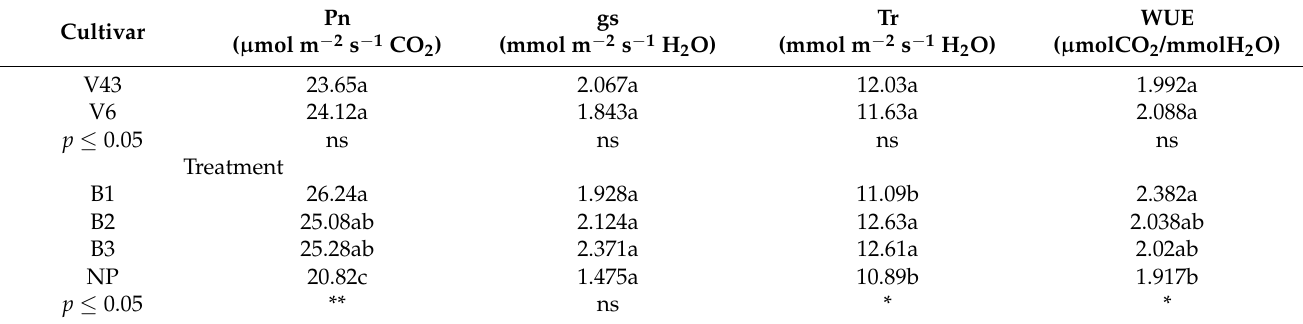
Table 2. Leaf–gas exchange parameters of tunnel-grown cayenne pepper cultivars in response to PGPR and chili residue synergy.